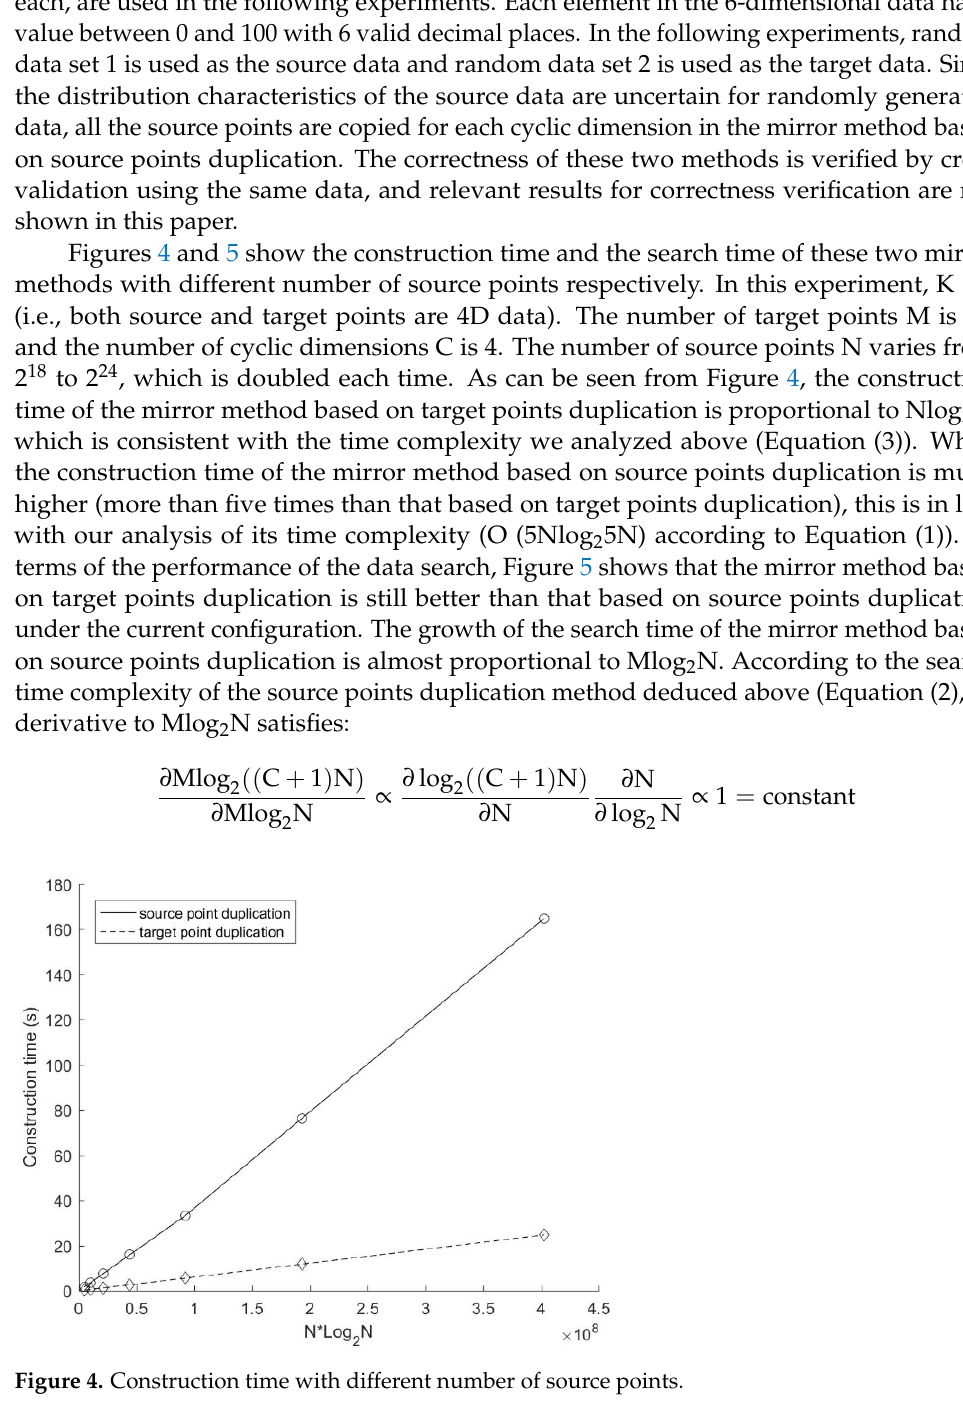
Figure 5. Search time with different number of source points.